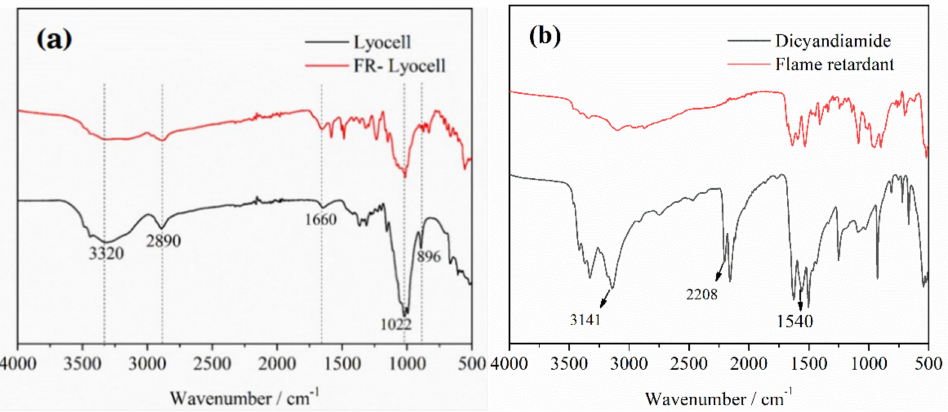
Figure 6. FTIR spectra of lyocell and FR − lyocell samples ( a ), Dicyandiamide and Flame retardant ( b